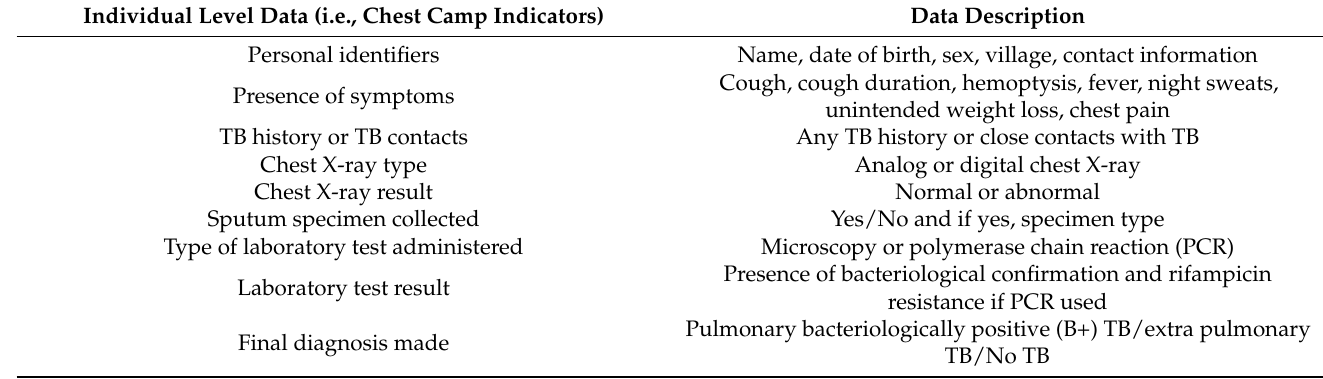
Table 1. Individual-level data captured in both PAPI and CAPI tools aggregated to chest camp level for quantitative